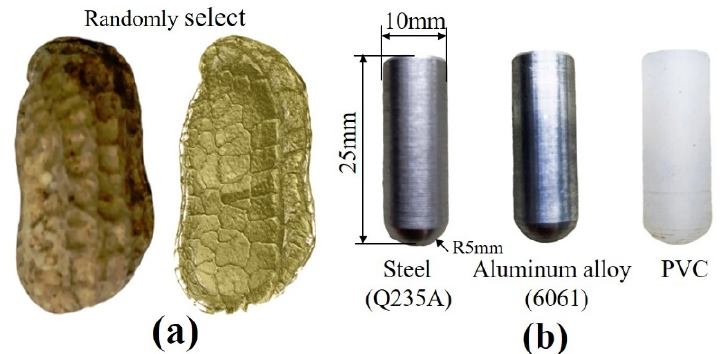
Figure 2. Specimens used in tests: ( a ) peanut and micro-CT-scanned images and ( b ) photographs of pin specimens of different materials.